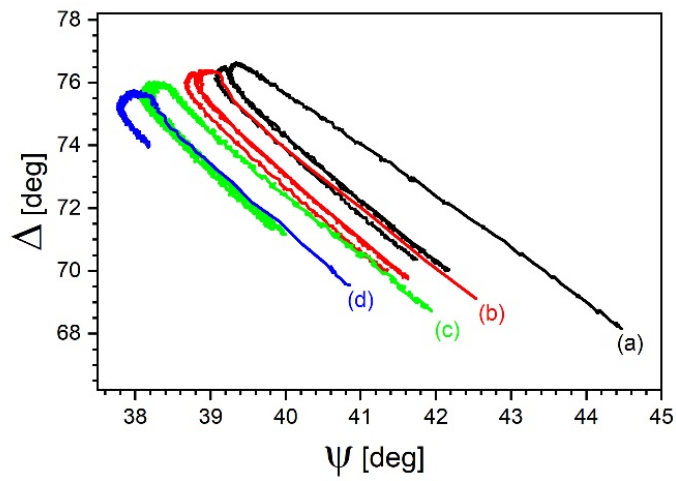
Figure 4. Extension of Figure 2 for the 20% sample. Dependence of ∆ over ψ during consecutive heating/cooling protocols—(a) the first one, (b) after two days, (c) after one month, (d) after next 2 months (in argon atmosphere). Data for wavelength of 1550 nm.